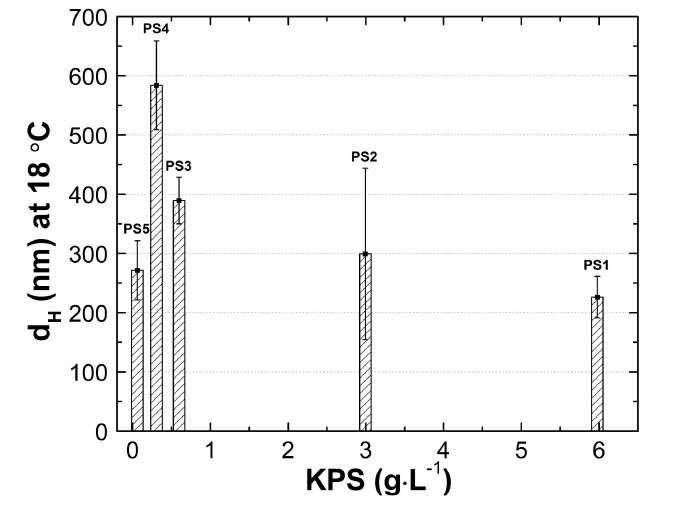
Figure 14. Hydrodynamic diameters of PS1–PS5 as a function of the concentration of anionic initiator, potassium persulfate